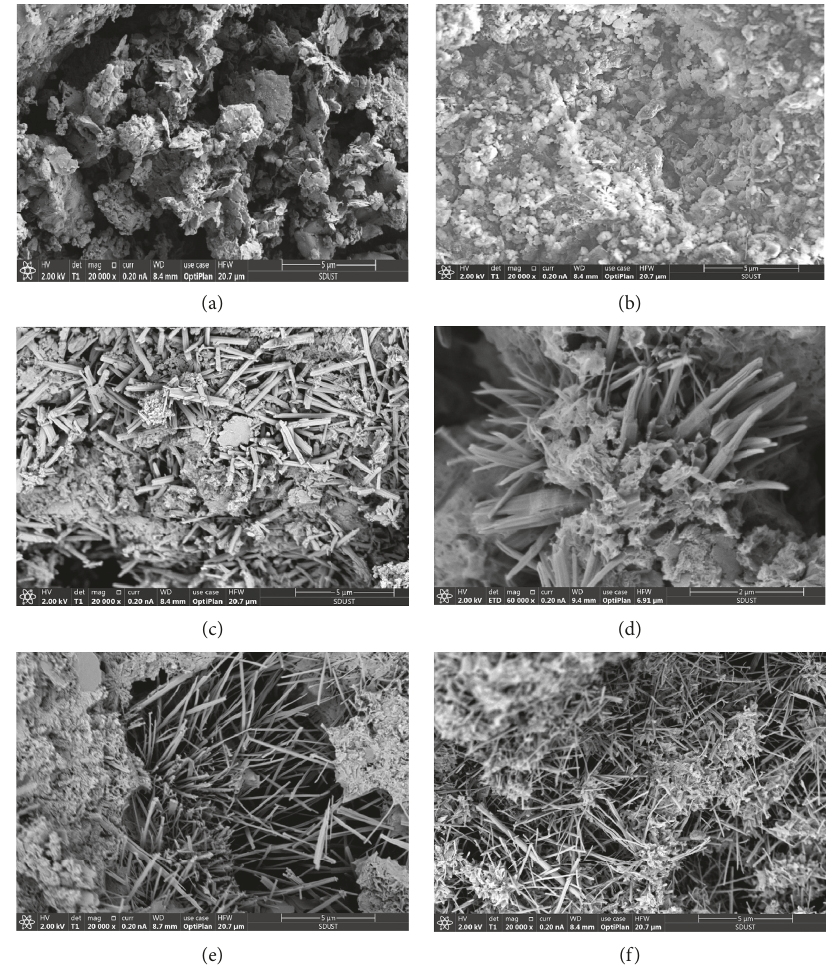
Figure 7: SEM results. (a) 35 ° C, water, 7 d; (b) 35 ° C, 3%, 7d; (c) 35 ° C, 7%, 7d; (d) 50 ° C, 7%, 7d; (e) 50 ° C, 5%,28 d; (f) 50 ° C, 7%,